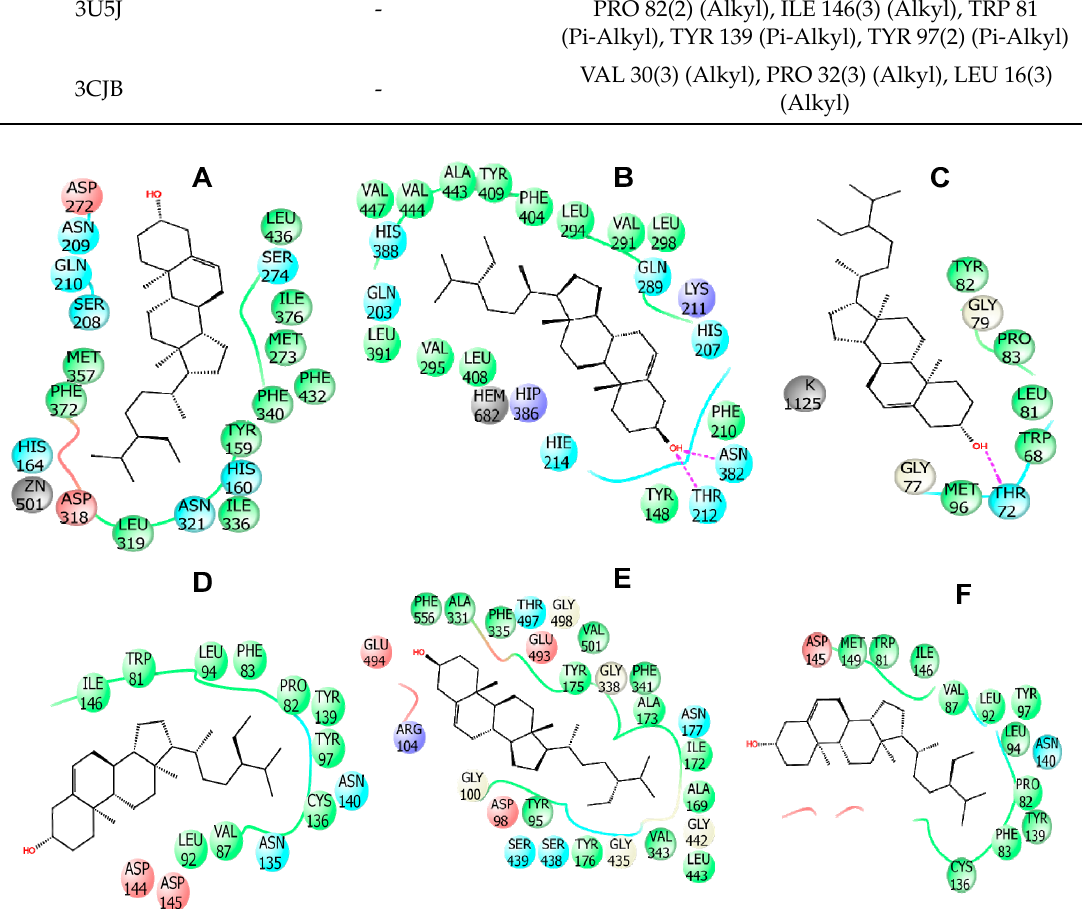
Figure 5. The best 2D representation found of the interactions between beta-sitosterol with ( A ) PDE4 enzyme (PDB ID: 4WCU), ( B ) COX-2 enzyme (PDB ID: 6COX), ( C ) potassium channel (PDB ID: 4UUJ), ( D ) bromodomain of human BRD4 in complex with midazolam (PDB ID: 3U5K), ( E ) serotonin transporter (PDB ID: 5I6X), and ( F ) bromodomain of human BRD4 in complex with alprazolam (PDB ID: 3U5J).